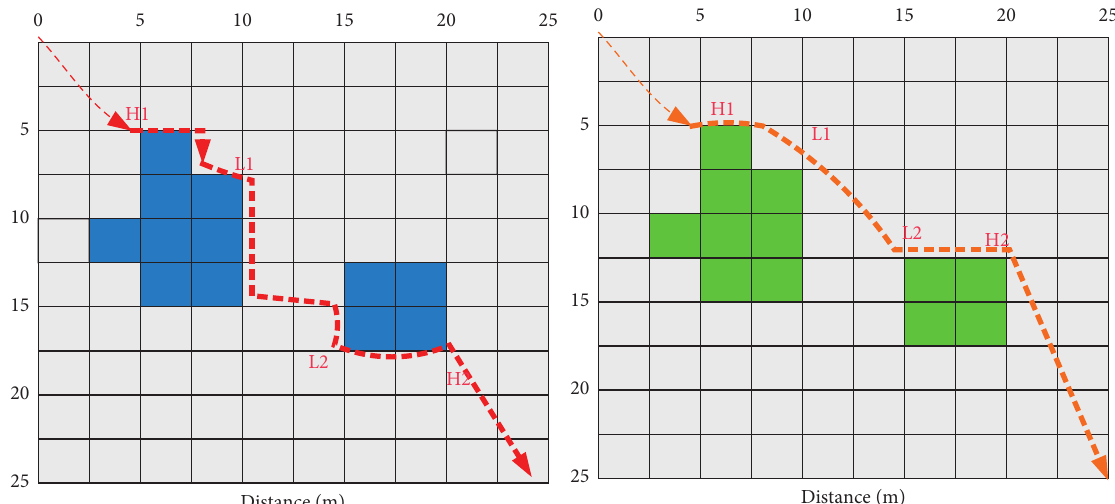
Figure 6: Comparison and analysis diagram of path obstacle avoidance optimization.